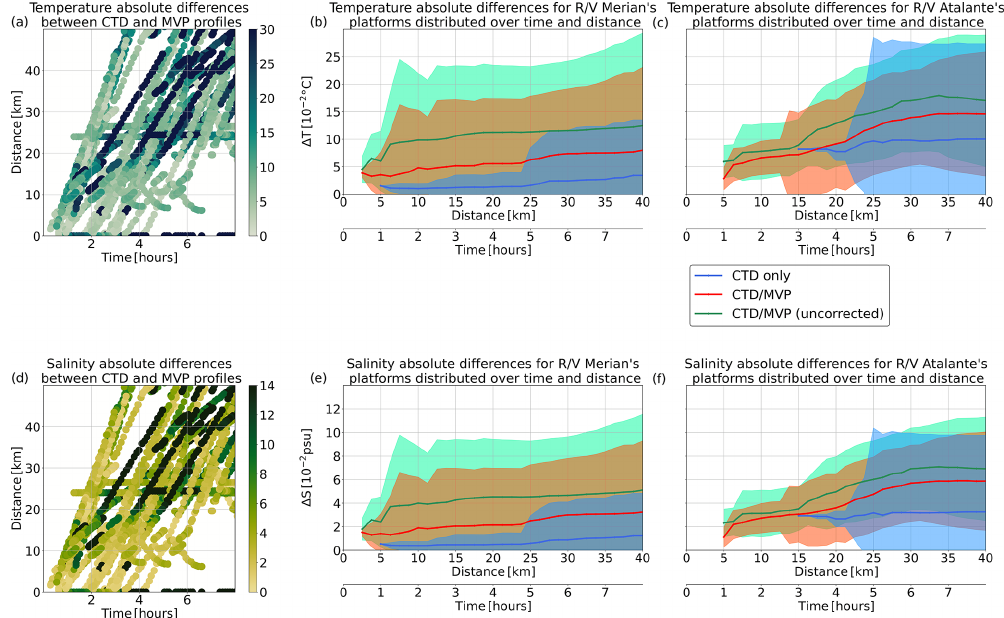
Figure 13. (a) Absolute temperature differences between CTD/MVP pairs of profiles on isopycnal levels, averaged and vertically distributed in time and distance. Each pair is composed of profiles from the same R/V (one CTD and one MVP). (b) Temperature differences as a function of time and distance for pairs of profiles from R/V Maria S. Merian . The differences are given in blue for pairs of CTD-only profiles, in red for pairs composed of one CTD and one MVP profile, and in green for pairs composed of one CTD and one uncalibrated MVP profile. Panel (c) is the same as (b) but for R/V L’Atalante . Panels (d) , (e) , and (f) are the same as above but for absolute salinity